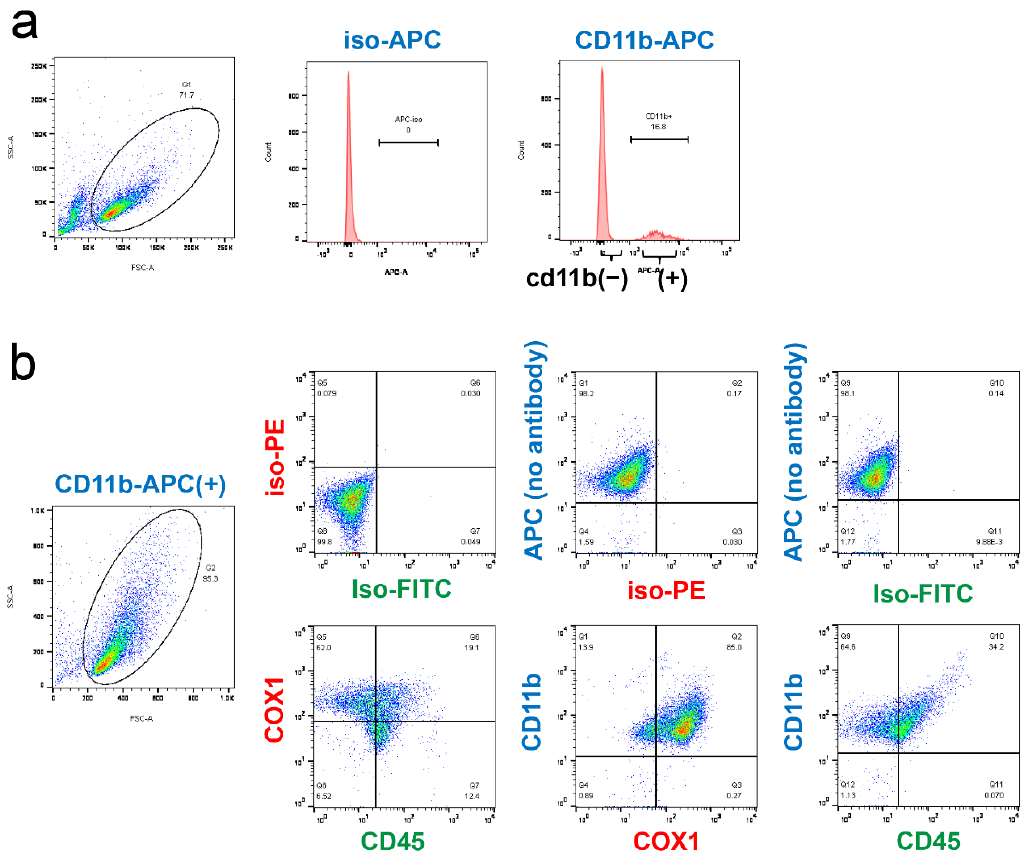
Figure 4. Analysis of CD45 and COX-1 expression in CD11b-positive cells collected from the CNS. ( a ) Cells dissociated from mouse brain were stained with CD11b-APC (right panel) or isotype-control (iso) (middle panel), which was followed by the sorting of APC-positive cells by flow cytometry. ( b ) CD11b-positive cells sorted in ( a ) were stained with CD11b-APC, CD45-FITC, and COX1-PE (lower panels), or with isotype controls for FITC and PE (upper panels). Note that all cells were APC-positive without staining, confirming successful sorting. Expression of COX-1 was shown in the CD45/CD11b-double positive cells of the CNS.